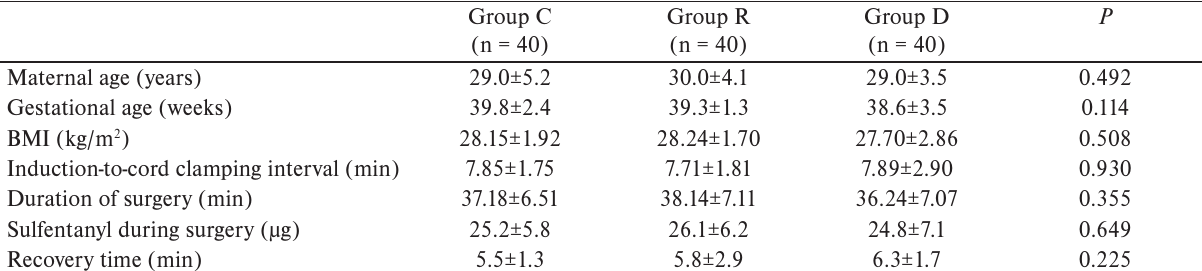
Table 1. Maternal and surgical